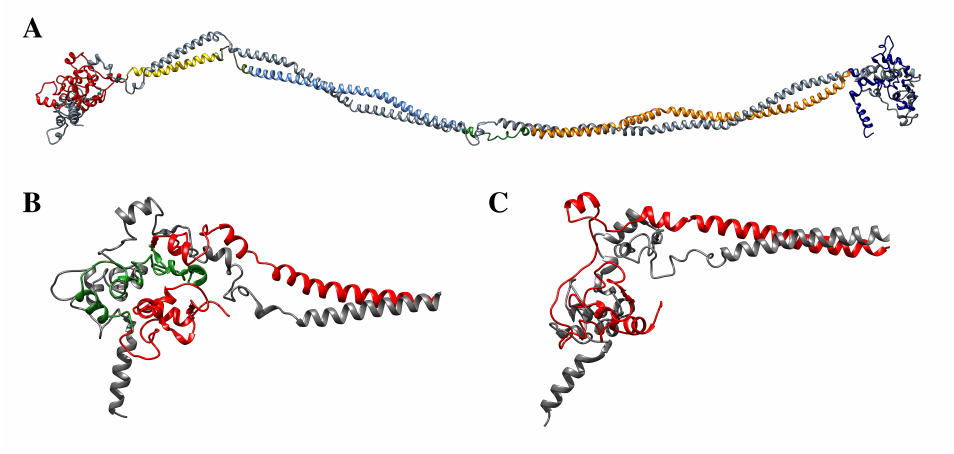
Figure 7. ( A ) Model of the K1/K10 dimer [16]. The major domains and the linker regions are identified by different colors. (red, head domain; yellow, coil 1A; cyan, coil 1B; orange, coil 2; blue, tail domain). K10 keratin is represented by gray ribbon and wires. ( B ) Detail of the head domain of the WT K1 keratin (red). The green color identifies the V1 domain. ( C ) Detail of the ∆ K1/K10 dimer model, characterized by the absence of the V1 domain, used as a starting structure for molecular dynamics